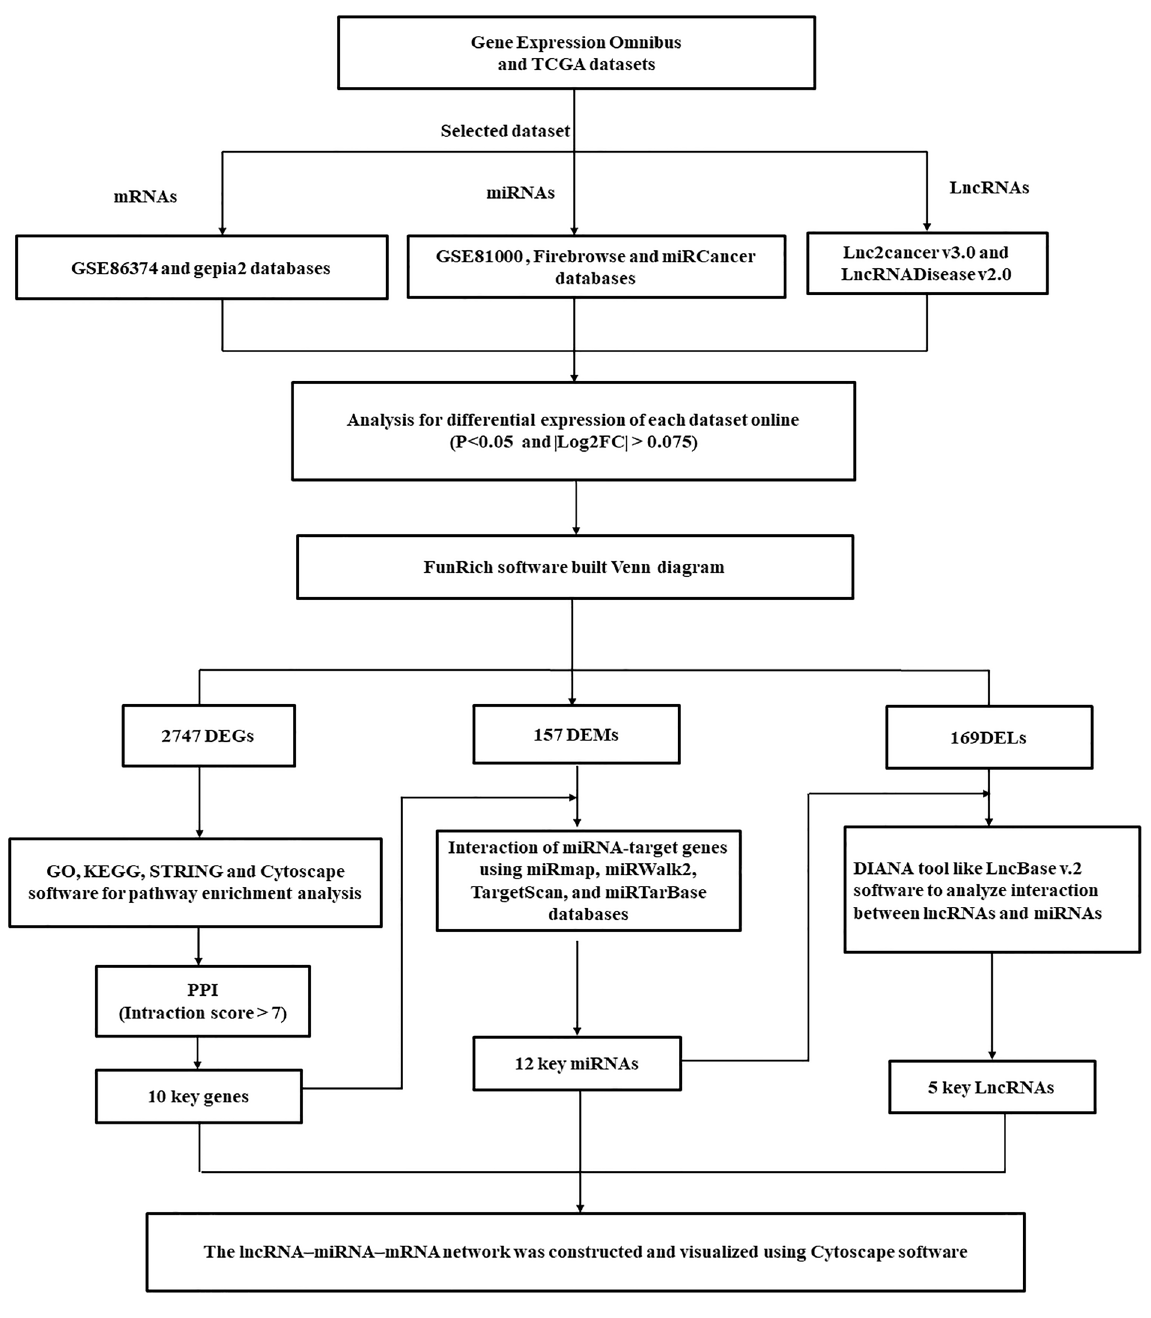
Figure 10. A flowchart diagram for the bioinformatics analysis in the present